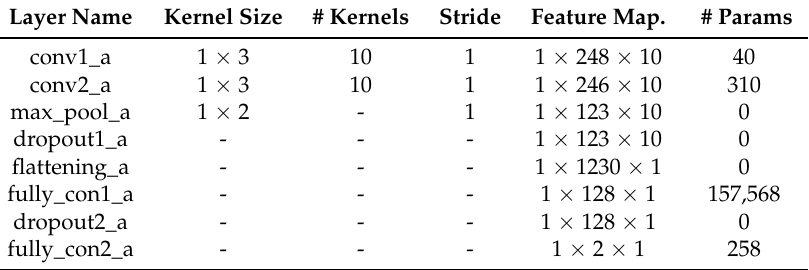
Table 1. Details of the CNN architecture a .